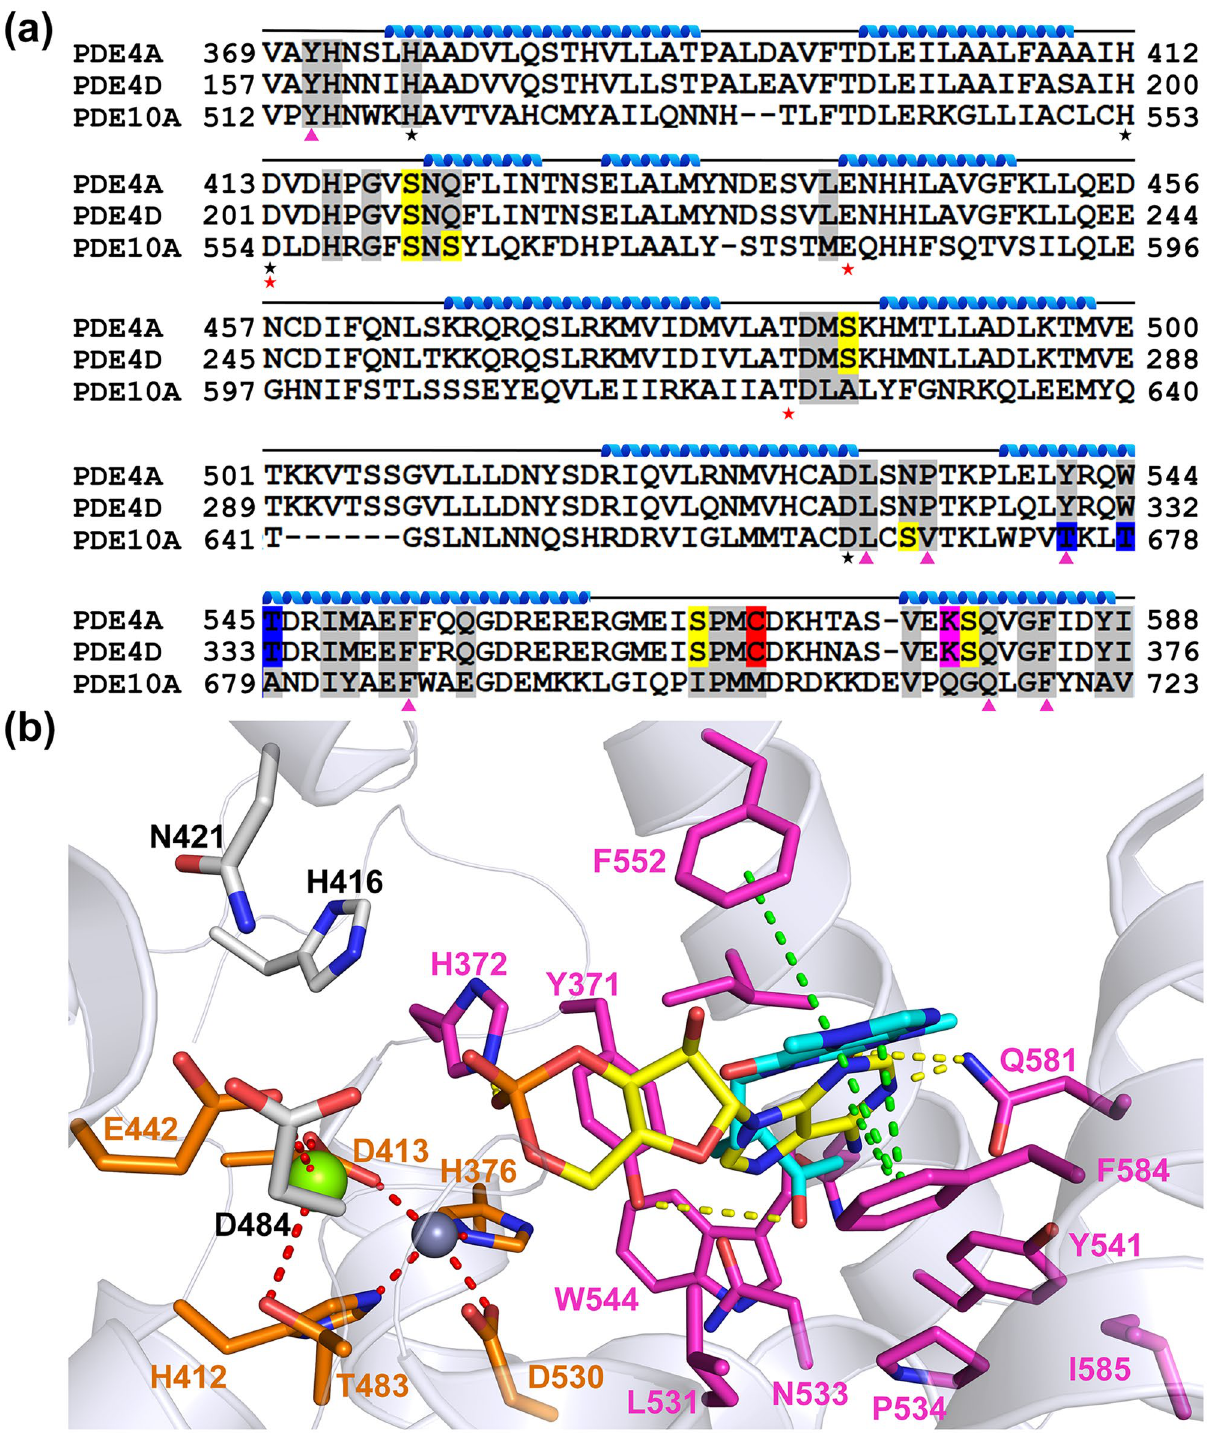
Figure 2. ( a ) Multiple sequence alignment of catalytic domain of PDEs functioning in the sperm. Binding pocket residues are highlighted in different colors. Nucleophilic residues such as Serine (S), Threonine (T), Cysteine (C) and Lysine (K) are highlighted in yellow, blue, red and pink colors respectively. Residues forming coordinated bond with Zn 2+ and Mg 2+ ions are represented with black and red star marks, respectively, above the residues. ( b ) PDE4A -PTX binary complex (PDB ID: 3TVX) docked with cAMP. PTX and cAMP are represented in cyan and yellow color sticks, respectively. The metal coordinating residues are represented in orange color sticks. The coordinate bonds between the residues and Zn 2+ (grey sphere) or Mg 2+ (green sphere) are shown as the red dashed lines, whereas, the π-stacking interactions between the ligand and the protein residues (magenta stick) and the H-bonds are shown as green and yellow dashed lines, respectively. Other binding pocket residues are represented in grey